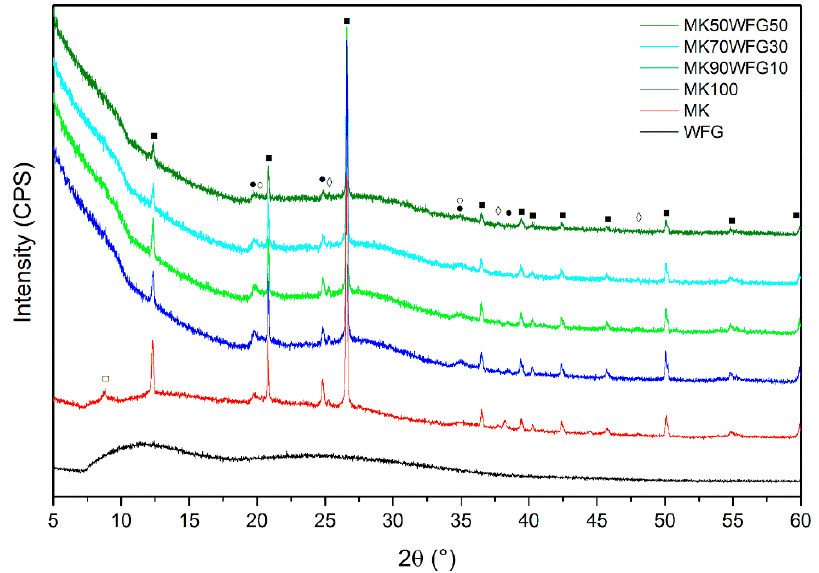
Figure 2. XRPD patterns of WFG, MK and of the produced alkali-activated materials (MK100, MK90WFG10, MK70WFG30 and MK50WFG50). The main peaks are indicated as follows: ▪ —quartz;